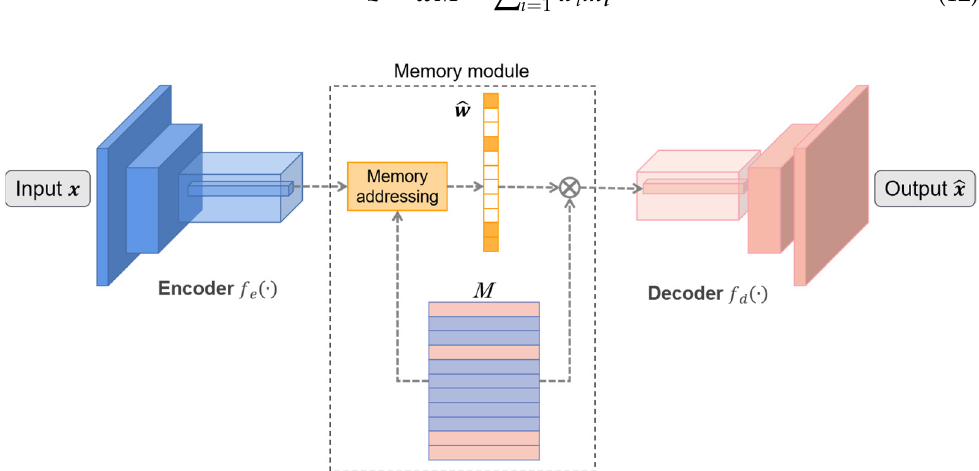
Figure 17. Diagram of memory-augmented deep autoencoder (MemAE).